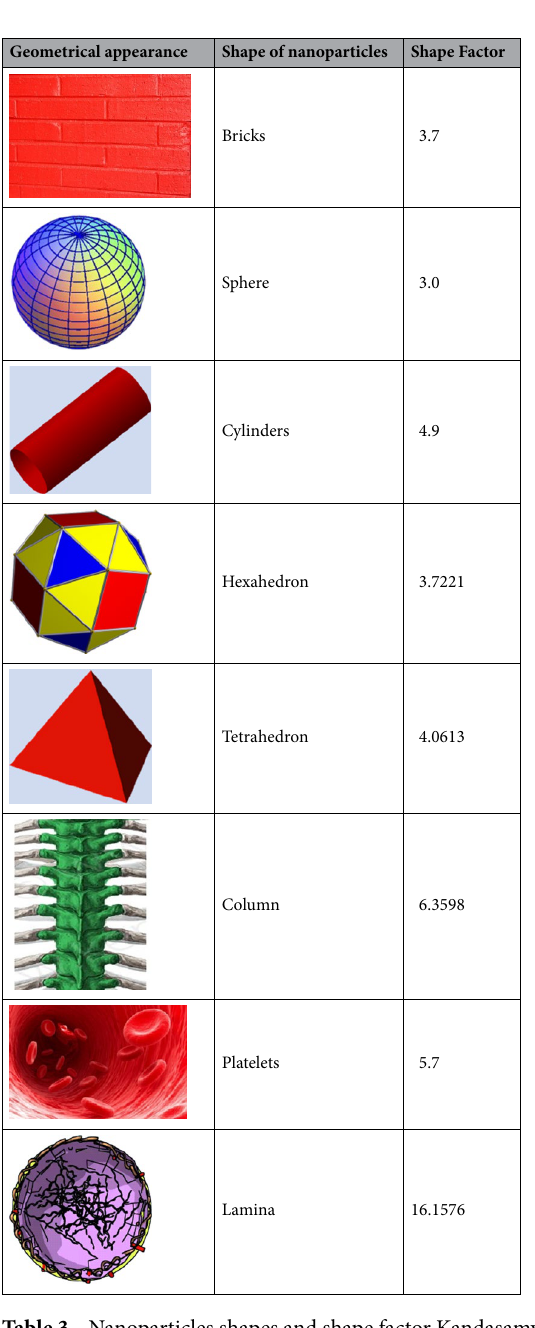
Table 3. Nanoparticles shapes and shape factor Kandasamy et al. 42